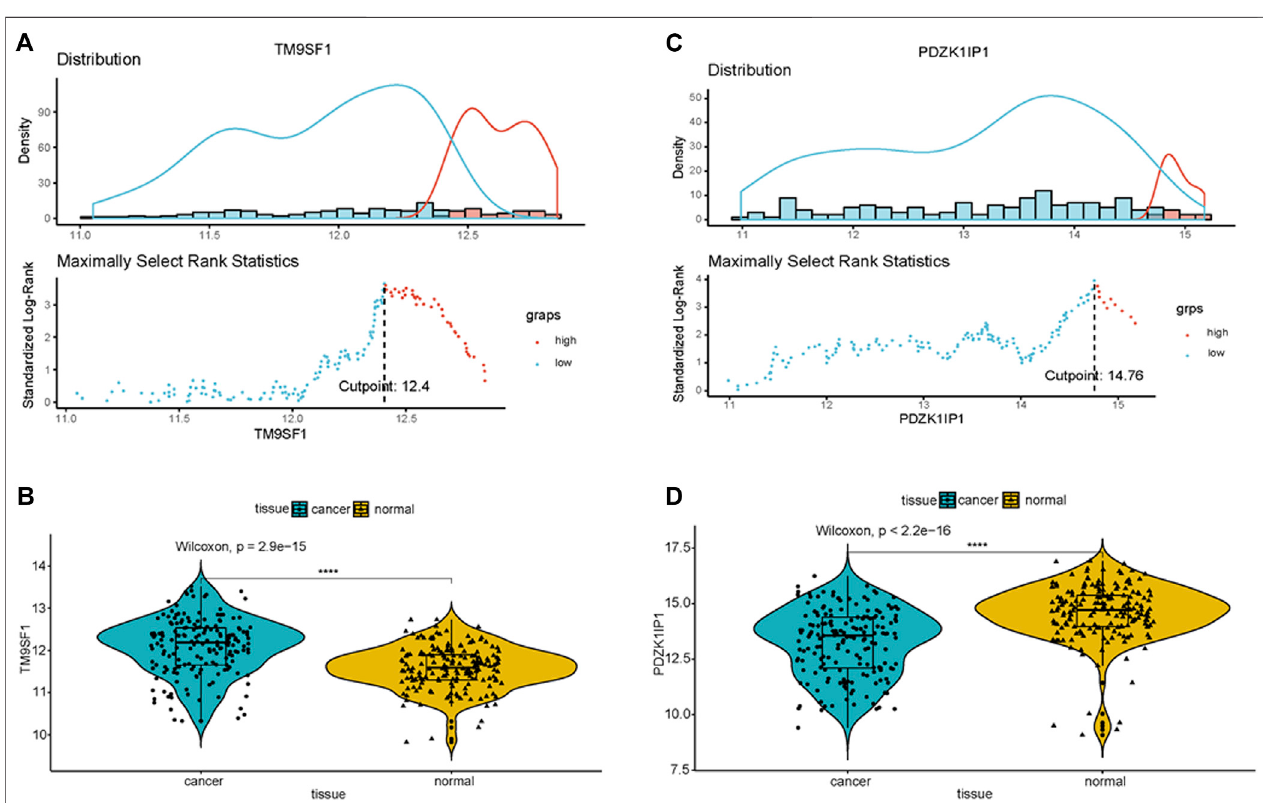
FIGURE3| PDZK1IP1andTM9SF1werede fi nedasmarkergenes (A,C) Cutpointofthemarkergeneswasobtained. (B,D) Violinplotshowedthattheexpression value of PDZK1IP1 gene was high in normal, TM9SF1 gene has high expression value in cancer.